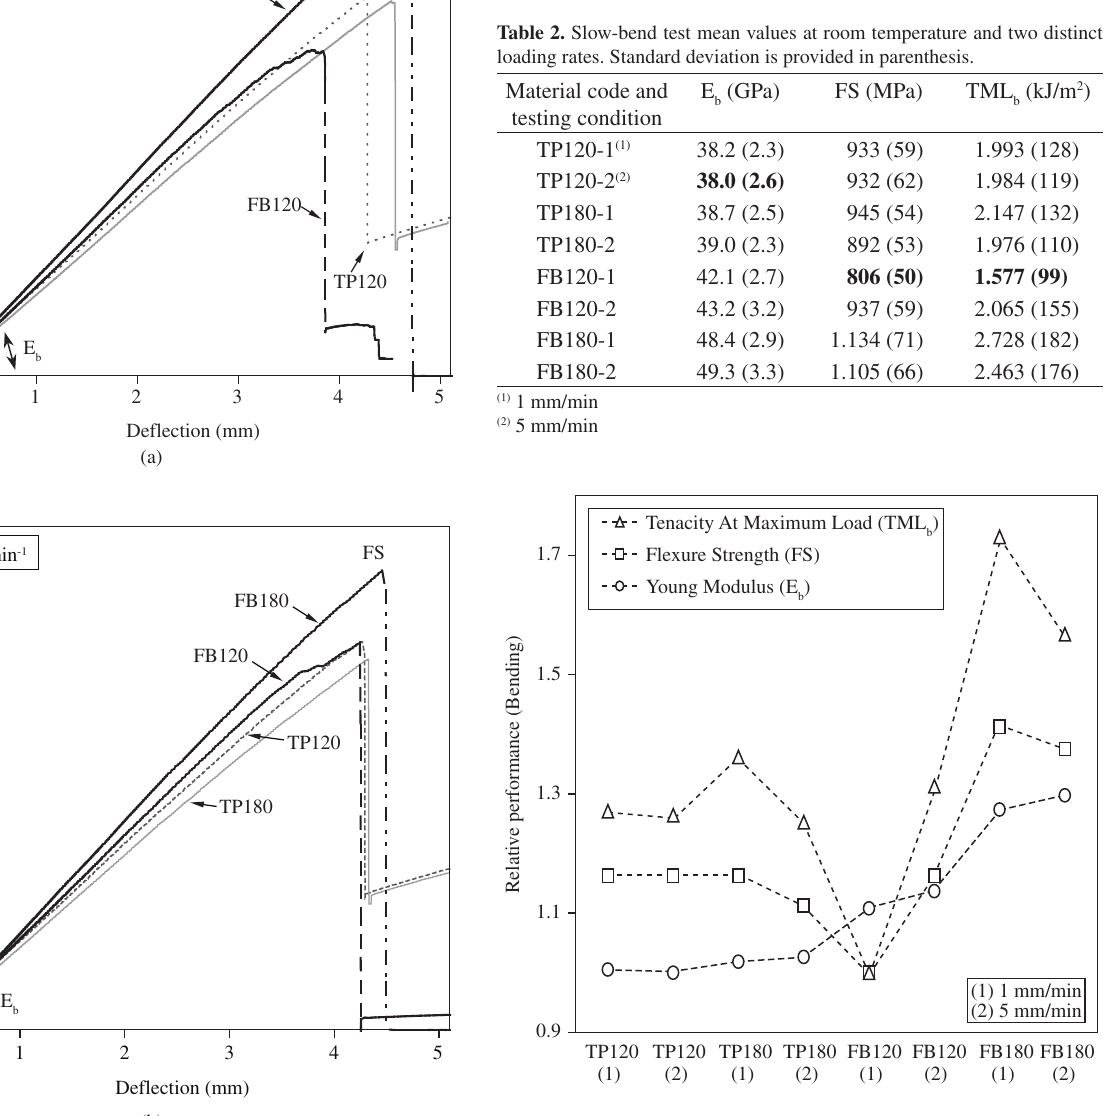
Figure 4. Relative (normalized) performance (based on mean results of Table 2) of the carbon-epoxy laminates under quasi-static bend loading at two different strain-rates. Point-to-point fits indicate the general trend of data only.